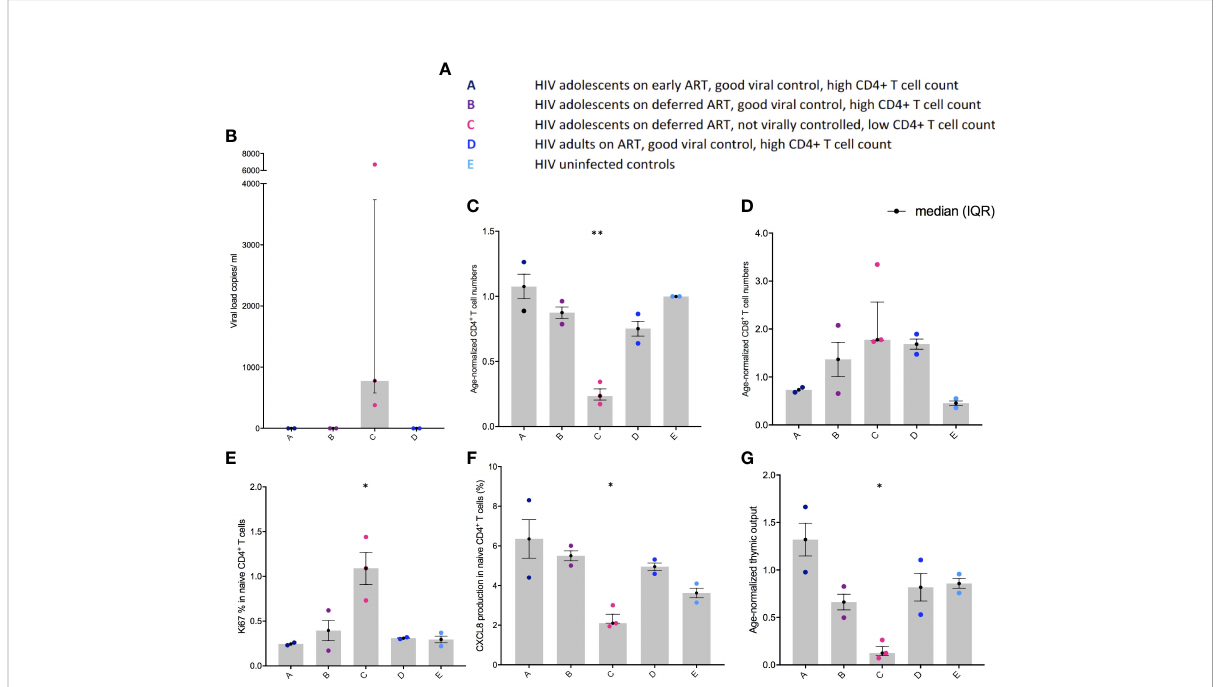
FIGURE 1 Viral load, age-normalised CD4 + and CD8 + T cell numbers, CXCL8 T cell production, and thymic output in adolescents with HIV-1. (A) Overview of the different groups. (B) Viral load (copies per ml). (C) Age-normalised CD4 + T cell counts. (D) Age-normalised CD8 + T cell counts. (E) Ki67 production in naïve CD4 + , CD45RA + , CD31 + T cells (%). (F) CXCL8 production in naïve CD4 + , CD45RA + , CD31 + T cells (%). (G) Thymic output (number of recent thymic emigrants measured by the mathematical model). Black lines: median(IQR). *P ≤ 0.05, **P ≤